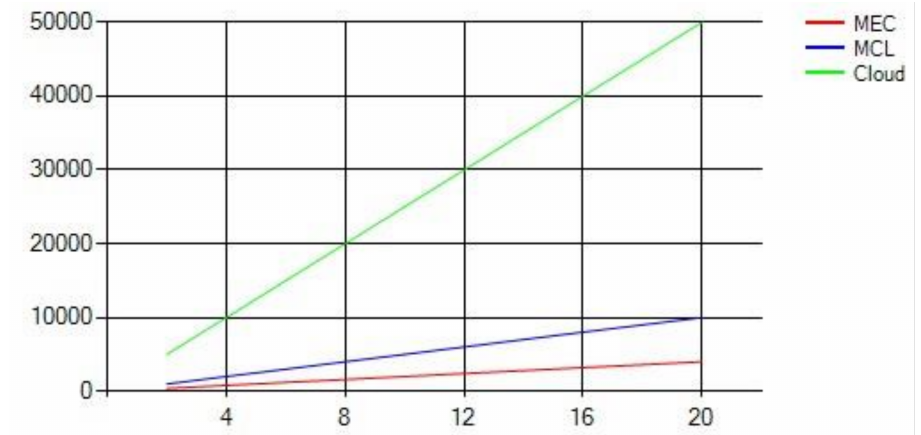
Figure 13. The communication delay of MEC, the MCL, and Cloud.